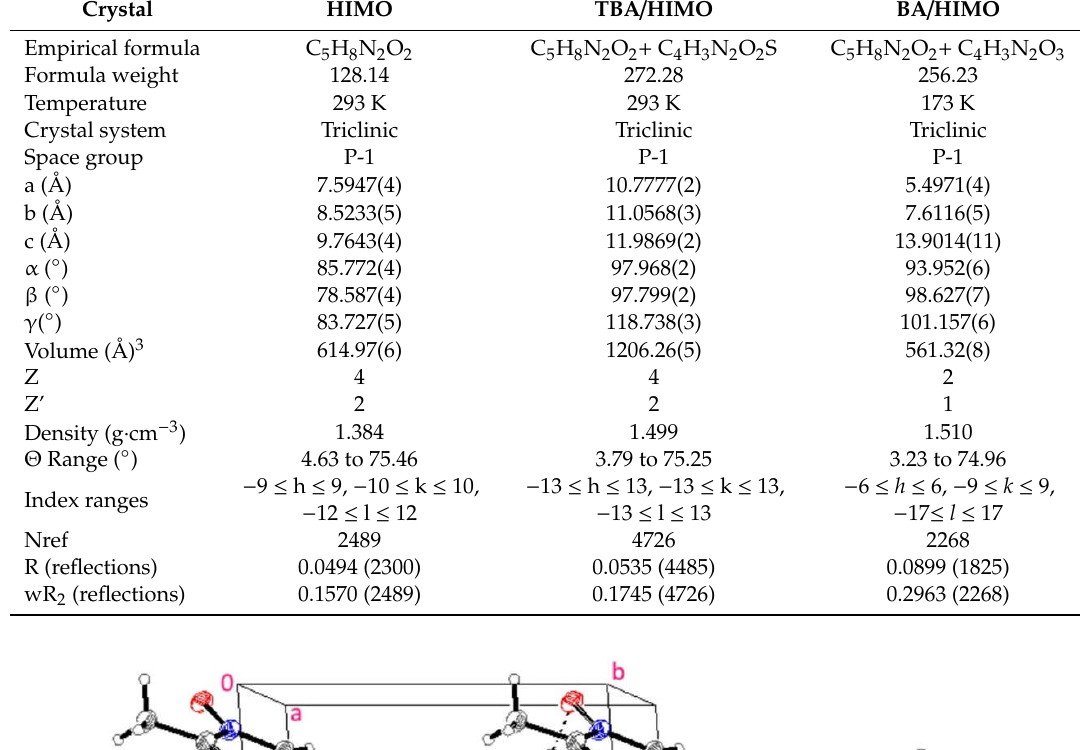
Table 1. Crystal parameters and refinement statistics.